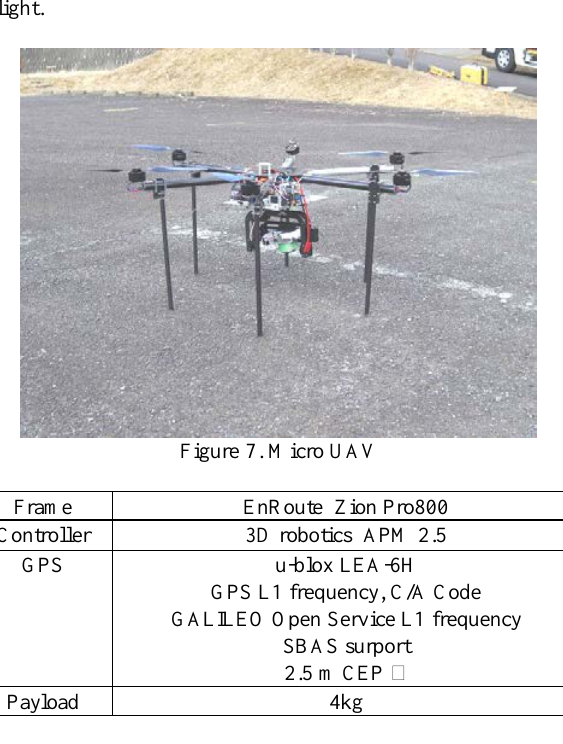
Table 1. Specification of Micro